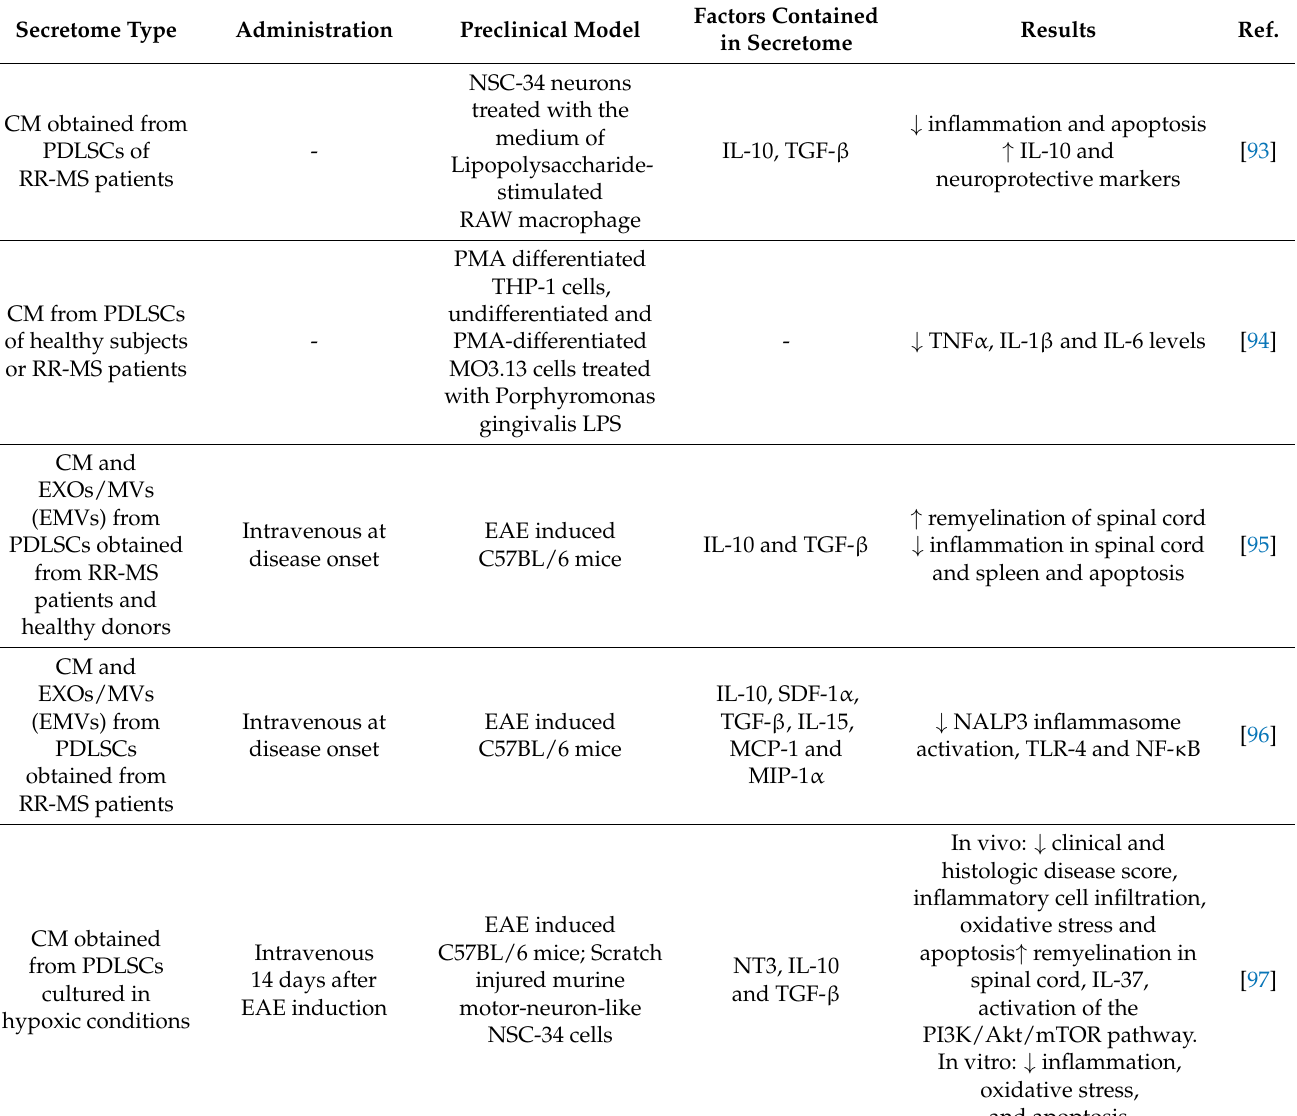
Table 4. Overview of studies involving PDLSC